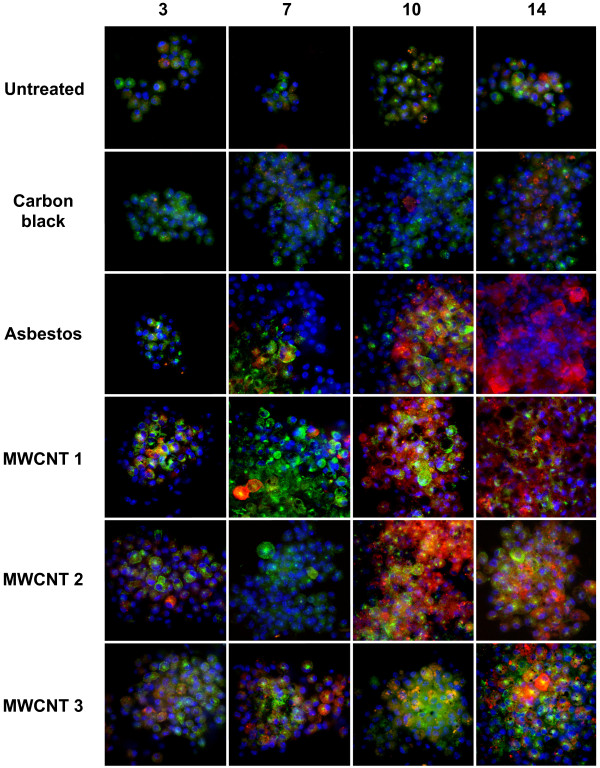
Induction of iNOS followed by arginase-1 (Arg-1) expression in 3D cultures. Cells were exposed to 0.5 μg/ml (0.38 μg/cm2) of particulates. After 3, 7, 10 and 14 days, cells were fixed and co-immunostained for iNOS (green), Arg-1 (red), and counterstained with DAPI. Cells exposed to asbestos and MWCNT 1 and 3 showed earlier co-expression of iNOS and Arg-1. The increasing levels of expression of these two mediators indicate progression towards a profibrotic response. Samples were analyzed by confocal microscopy using the appropriate filters. Photographs are representative of Z-stacks of three individual samples. Magnification: 400×.